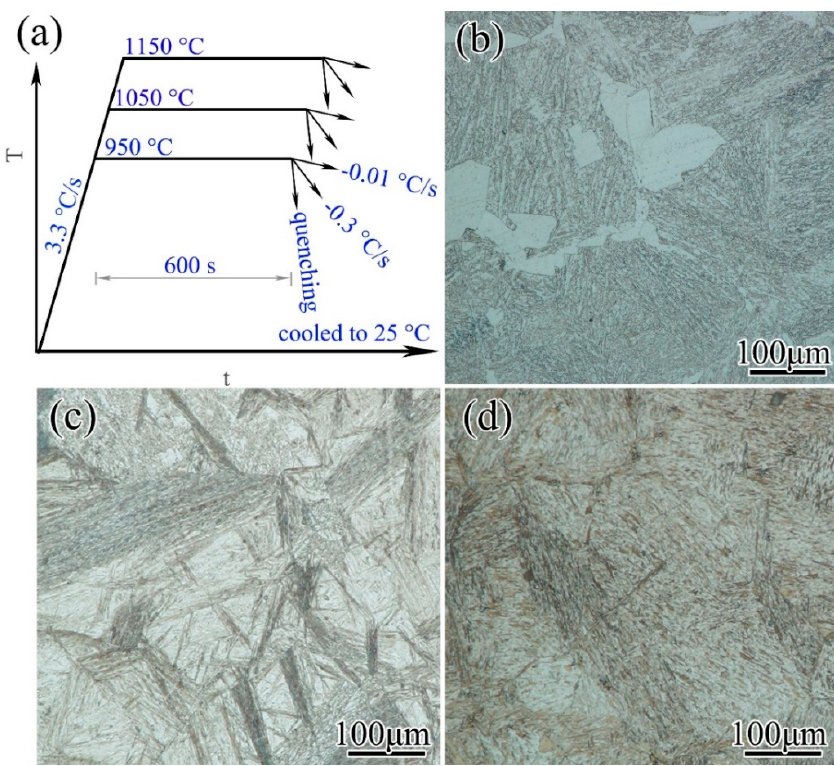
Figure 2. Temperature curves and microstructures of 300M steel. The temperature curves were shown in ( a ). It showed the etching results of specimens held at 1150 °C for 600 s and cooled at ( b ) − 0.01